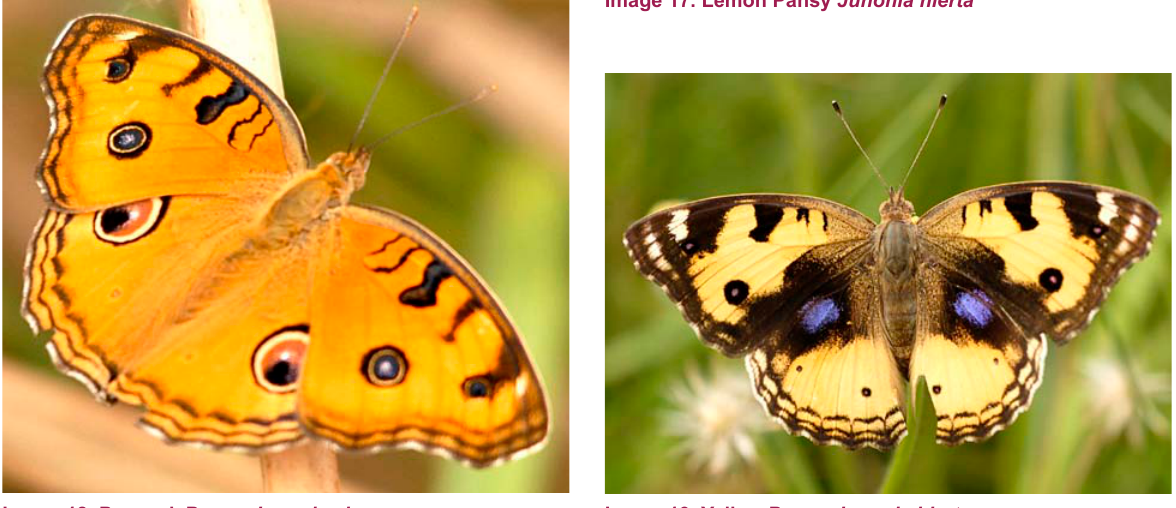
Image 19. Yellow Pansy Junonia hierta